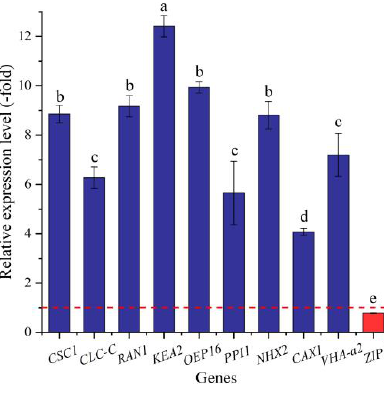
Figure 12. The RELs of genes directly associated with ion transport in A. venetum seeds at 300 mmol/L NaCl vs. CK (mean ± SD, n = 3). Different letters represent a significant difference ( p < 0.05) among different genes. The red dotted line differentiates UR (>1) and DR (<1).